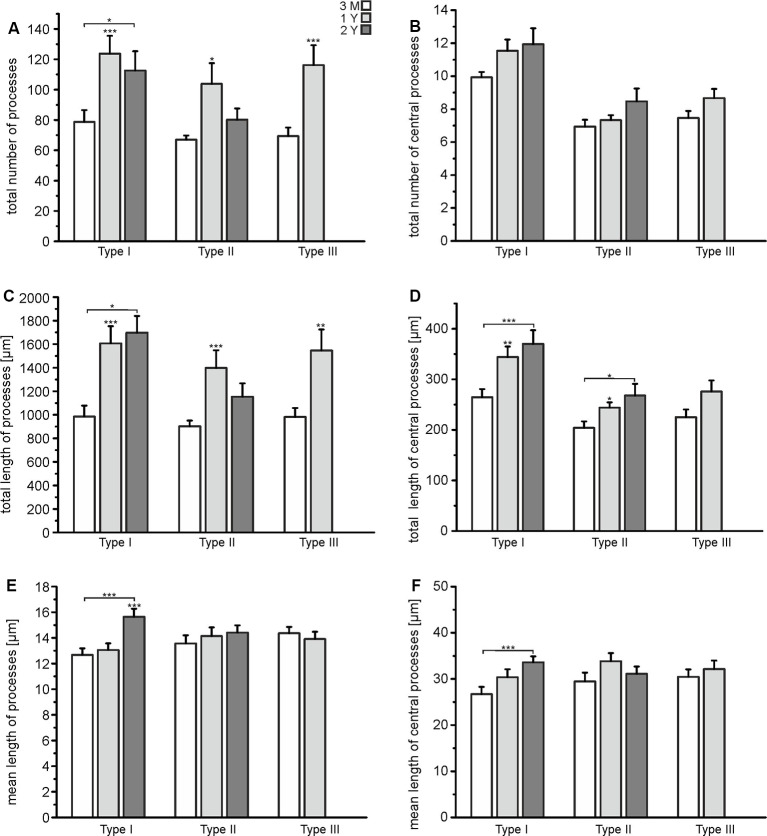
Quantification of astrocyte complexity. (A) The total number of processes of each type of astrocyte for each age group. (B) The total number of central processes of each type of astrocyte for each age group. (C) The total length of all astrocytes of each type of astrocyte for each age group. (D) The total length of all central processes of each type of astrocyte for each age group. (E) Mean length of all processes for each type of astrocyte and each age group. (F) Mean length of central processes for each type of astrocyte and each age group. *p < 0.05; **p < 0.01; ***p < 0.001.